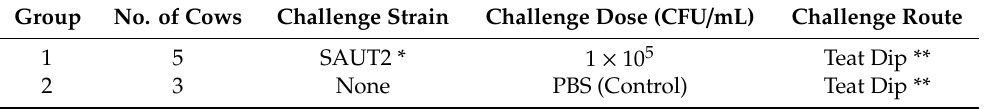
Table 1. Experimental challenge (infection) protocol of S. aureus. Group No. of Cows None PBS (Control) Teat Dip